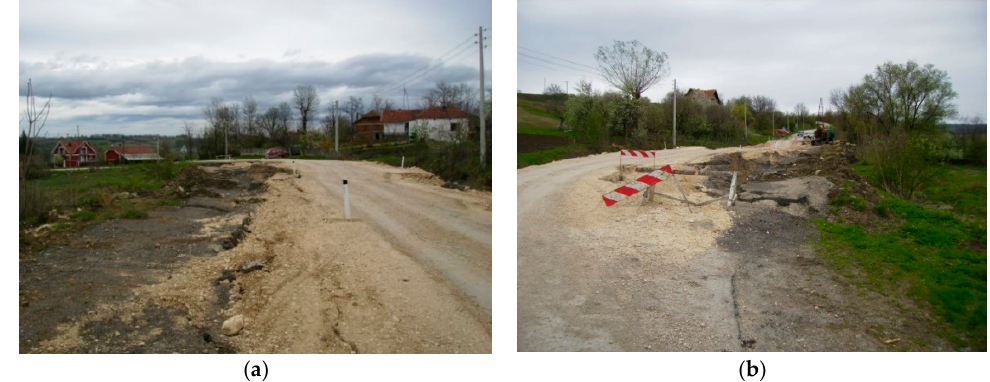
Figure 8. Parts of the road affected by the landslide at toponyms “Lubnica” ( a ) left view; ( b ) right view) [29].